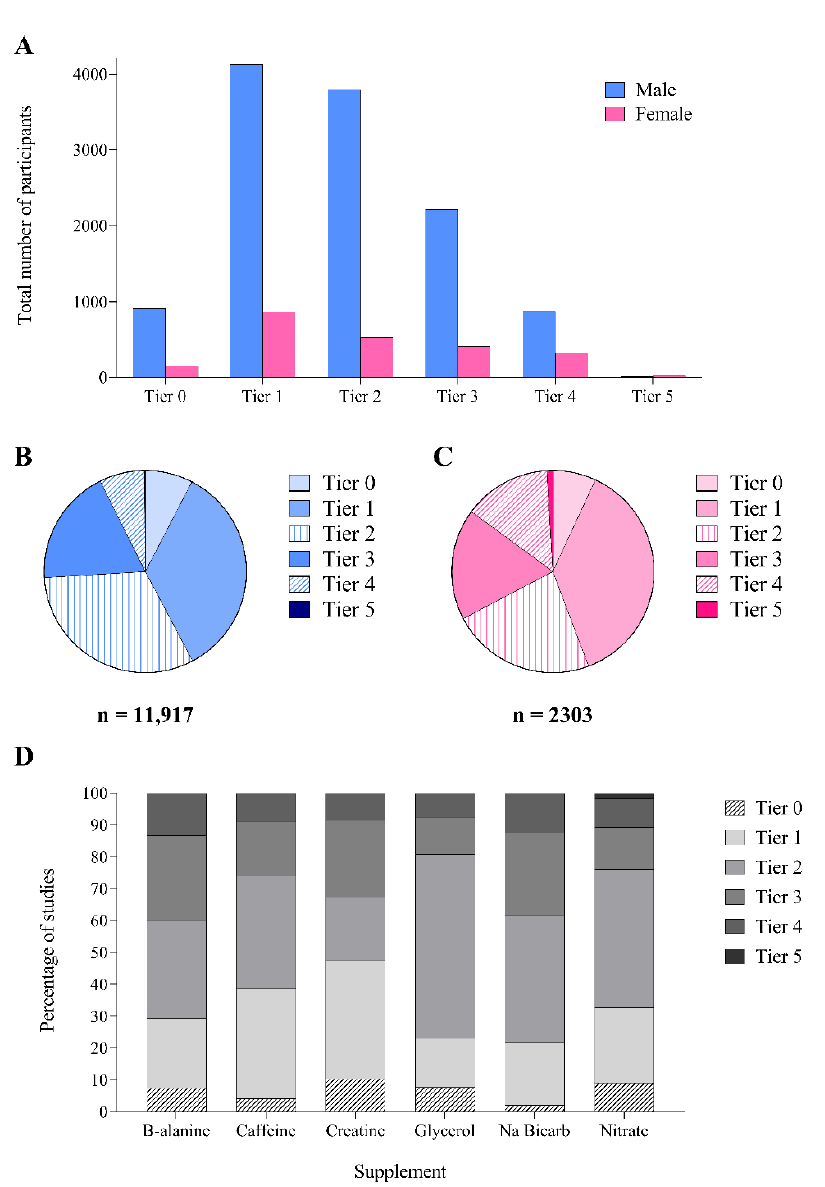
Figure 4. The total ( A ) and proportion ( B , C ) of male and female participants in each athletic tier [20]: Tier 0 (sedentary), Tier 1 (recreationally active), Tier 2 (trained/developmental), Tier 3 (highly trained/national), Tier 4 (elite/international) and Tier 5 (world-class). ( D ) The proportion of partici- pants in each athletic tier according to the supplement investigated. Only classifiable participants are reported in all figures.